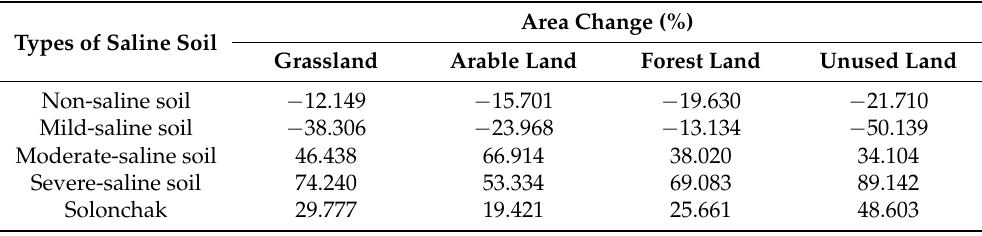
Table 12. Changes in different grades of saline soil based on land use types in the study area from 2016 to 2019 (unit: